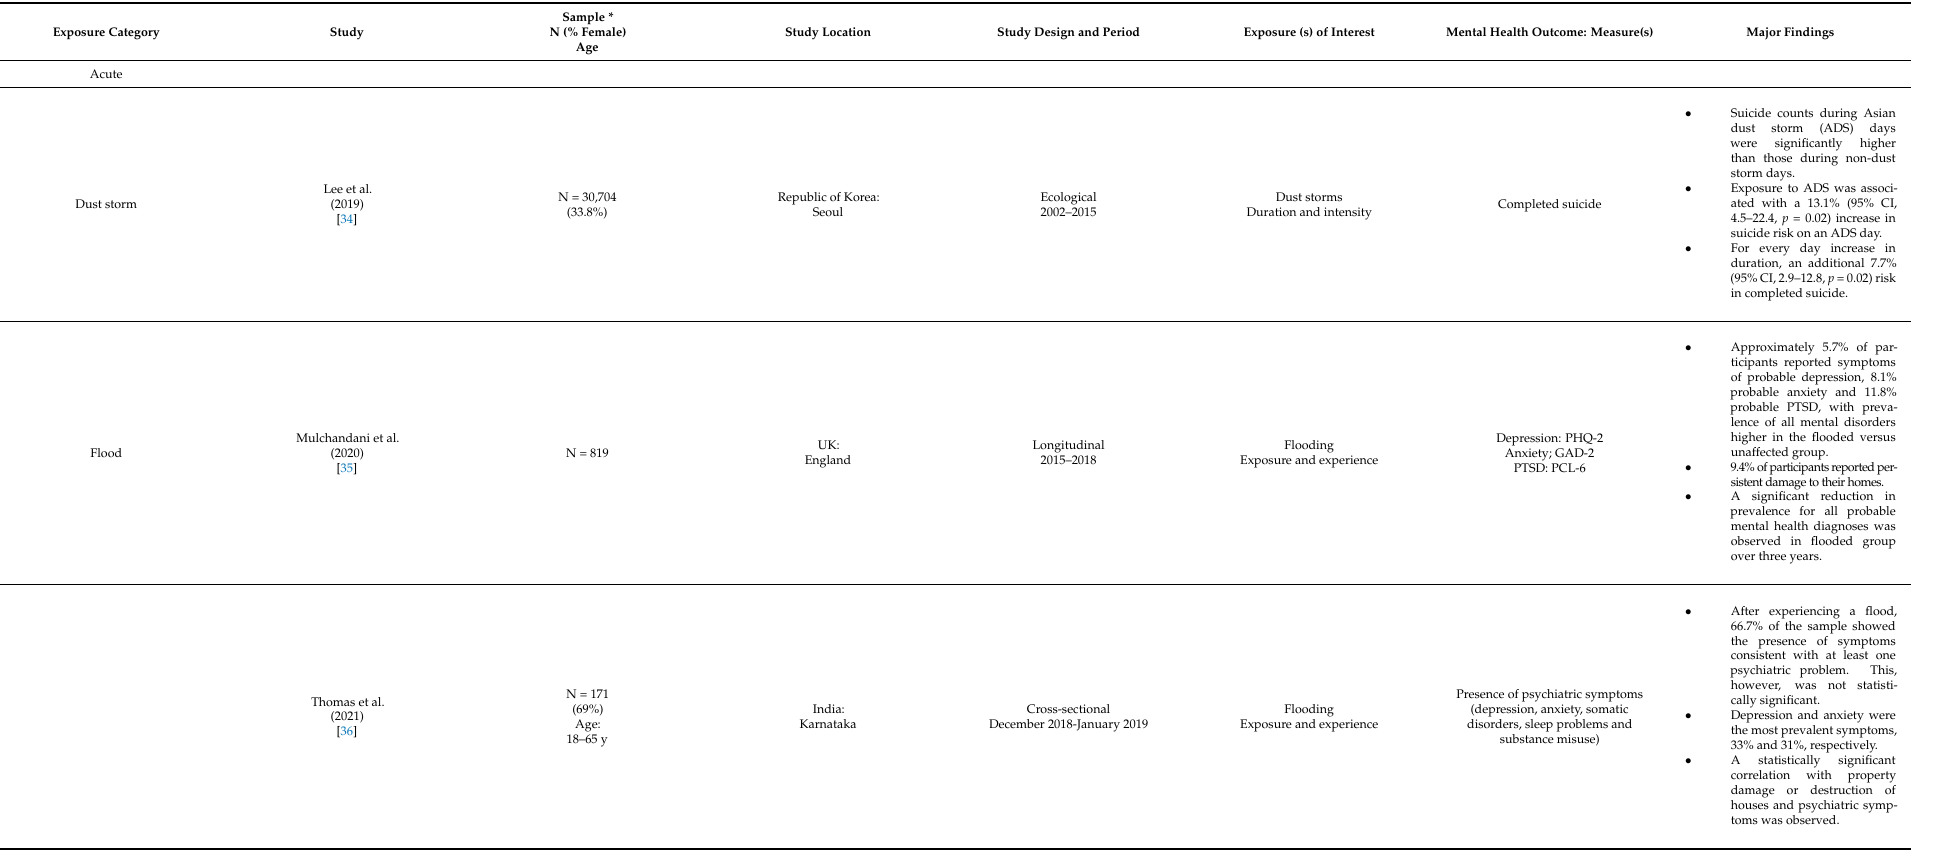
Table 1. Recent studies categorized by type of climate change-related